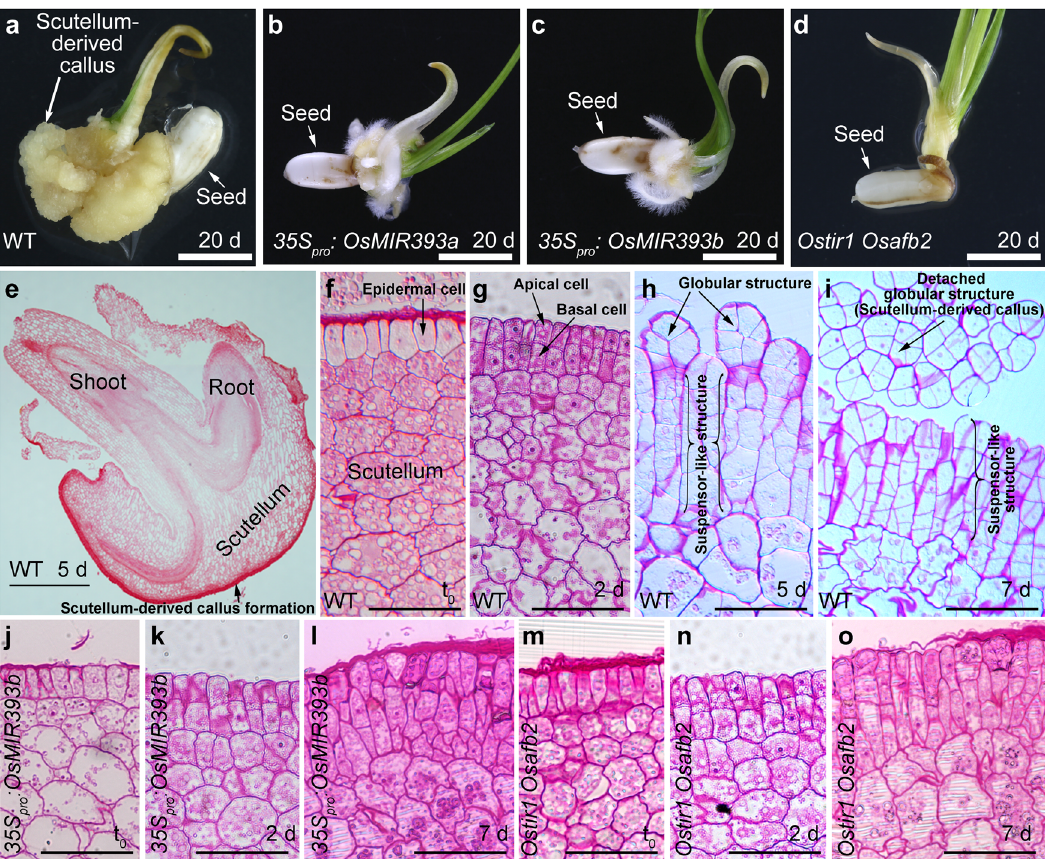
Fig. 1 Developmental framework of auxin-mediated callus formation from scutellum in rice. a – d Tissue culture of rice mature seeds from wild-type (WT) ( a ), 35S pro :OsMIR393a ( b ), 35S pro :OsMIR393b ( c ), and Ostir1 Osafb2 ( d ) on CIM for 20 d. We tested more than 90 wild-type seeds, and all of them formed scutellum-derived callus. We tested more than 30 seeds from 35S pro :OsMIR393a , 35S pro :OsMIR393b , or Ostir1 Osafb2 , and none of them formed scutellum- derived callus. e – i Sections showing callus formation from scutellum ( e ) of wild-type rice seeds on CIM at t 0 ( f ), 2 d ( g ), 5 d ( e , h ), and 7 d ( i ). See Supplementary Fig. 2 for details. j – o Sections showing cell division from scutellum of 35S pro :OsMIR393b ( j – l ) and Ostir1 Osafb2 ( m – o ) seeds on CIM at t 0 ( j , m ), 2 d ( k , n ), and 7 d ( l , o ). Scale bars, 5 mm ( a – d ), 500 μ m ( e ), 50 μ m ( f – o